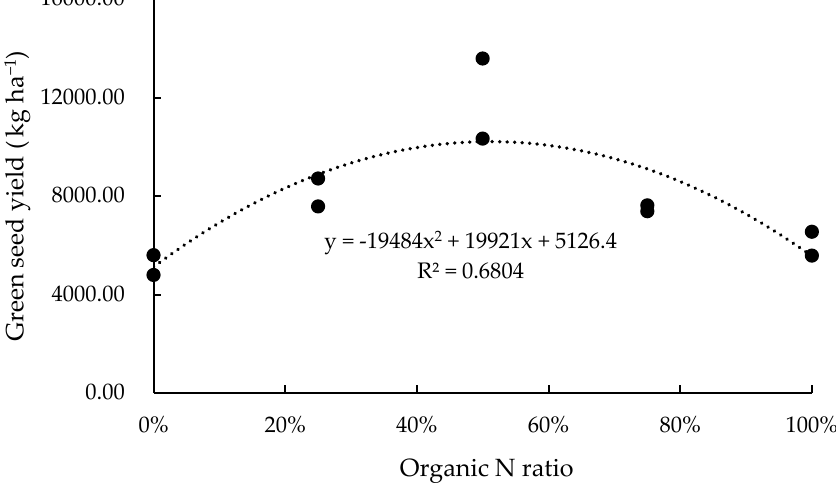
Figure 1. The relationship between organic N ratio and the green seed yield.